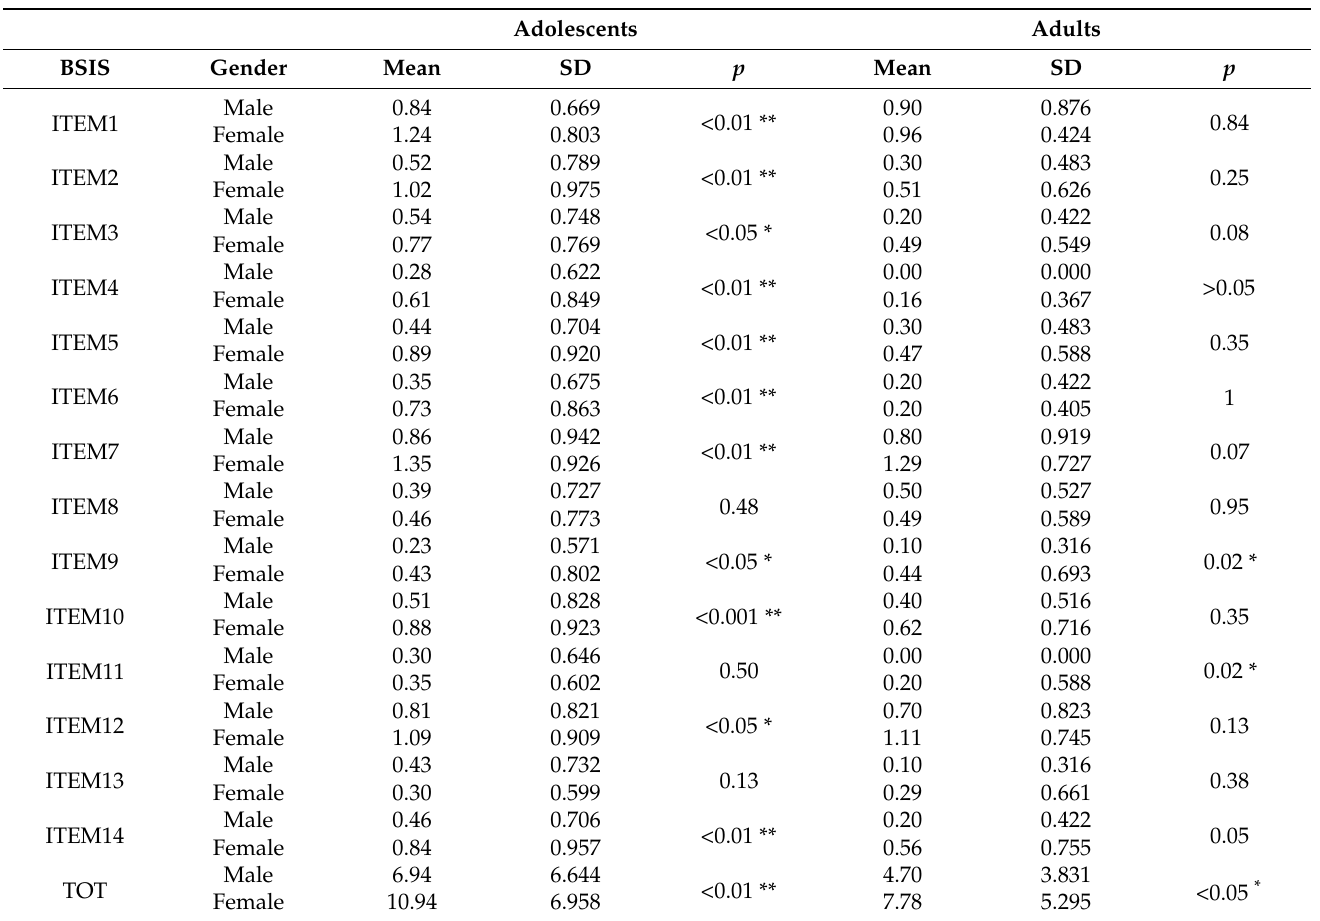
Table 6. Gender differences in BSIS